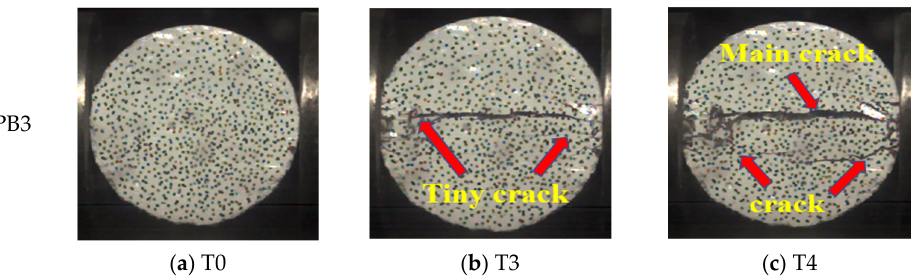
Figure 9. Crack failure modes of each group of specimens at different moments: ( a ) The crack failure form corresponding to the time before cracks appeared in the specimen (i.e., T0); ( b ) the crack failure form corresponding to the time when cracks first appeared in the specimen (i.e., T3); ( c ) the crack failure form corresponding to the moment when the main crack first appeared in the specimen (i.e., T4). As can be seen from Table 9, the time required by S2P0 (the single addition steel fiber Table 9. Corresponding schedule of crack failure form in each group. group) to arrive at time T4 was significantly longer than that of S0P0 (the reference group), increasing by 50.0%. The time required for SPB1, 2, and 3 (the mixed fiber group) to arrive